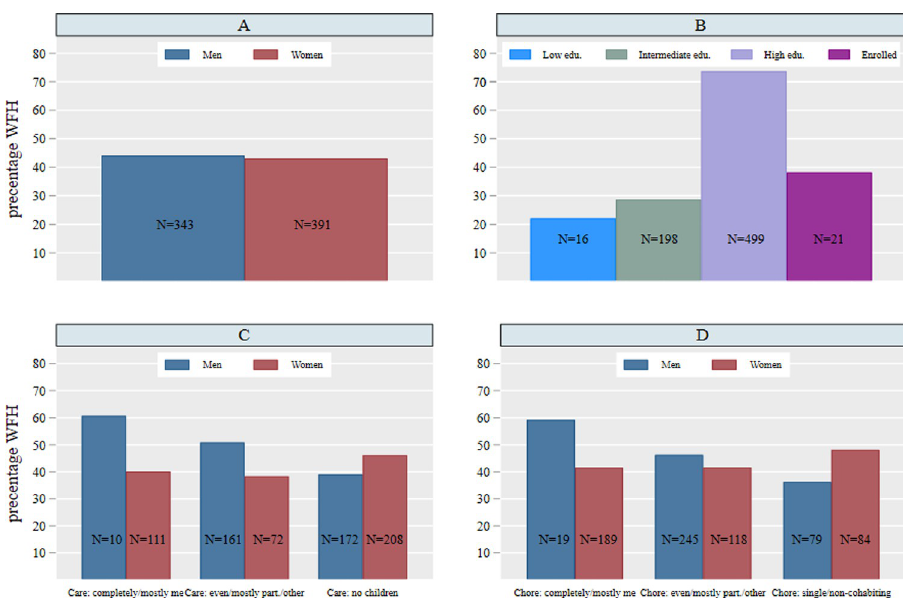
Fig 1. Work from home by gender (A), educational level (B), care (C) and household chores (D). Note: Based on pairfam -COVID-19 survey and pairfam Release 12.0, own calculations, weighted.